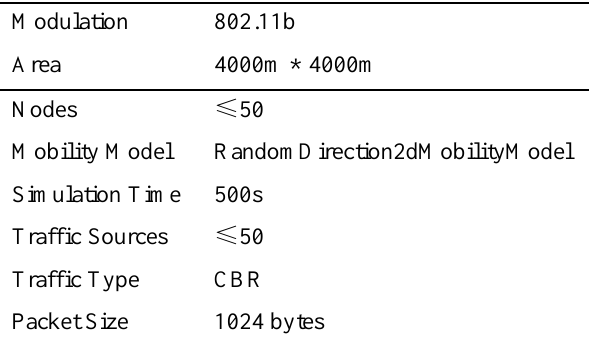
Table 7 Simulation parameters.